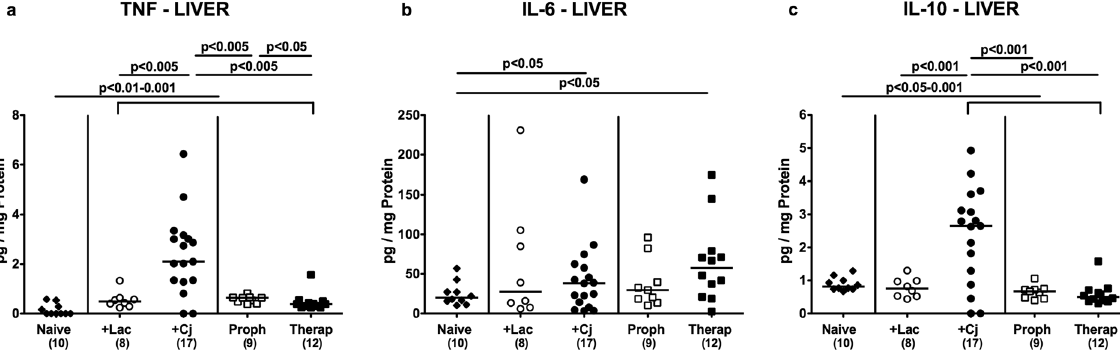
Figure 6. Secretion of pro- and anti-inflammatory mediators in livers of C . jejuni strain 81–176 and/or L . johnsonii reassociated secondary abiotic mice. Secondary abiotic mice were perorally infected with C . jejuni strain 81–176 (Cj) and associated with L . johnsonii (Lac) either 14 days before (prophylactic regimen, Proph; white squares) or 7 days thereafter (therapeutic regimen, Therap; black squares) and compared to mono- associated mice ( + Lac, white circles; + Cj, black circles). ( a ) TNF, ( b ) IL-6 and ( c ) IL-10 concentrations were determined in ex vivo biopsies derived from livers at days 21 or 28 following initial C . jejuni or L . johnsonii infection, respectively. Naive (N) mice (black diamonds) served as uninfected controls. Medians (black bars), levels of significance (p-value) determined by one-way ANOVA test followed by Tukey post-correction test for multiple comparisons and numbers of analyzed animals (in parentheses) are indicated. Data were pooled from three independent experiments.